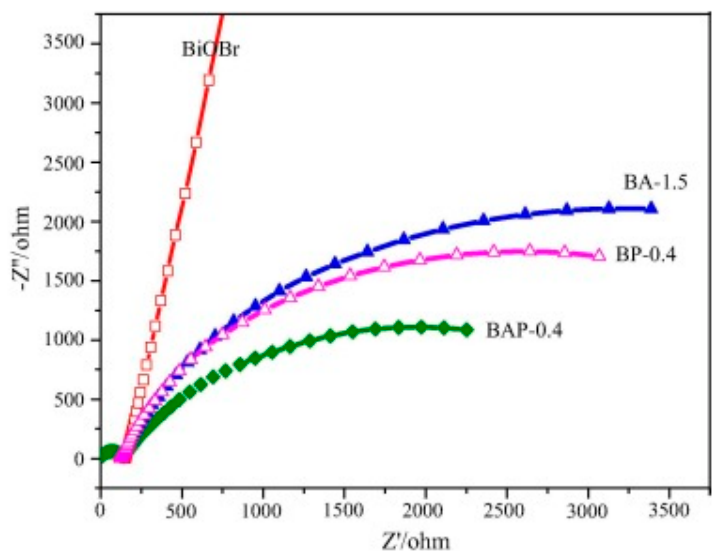
Figure 8. EIS Nyquist plots of BiOBr, BiOBr–Ag–1.5, BiOBr–PPy–0.4, and BiOBr–Ag–PPy–0.4 [61].